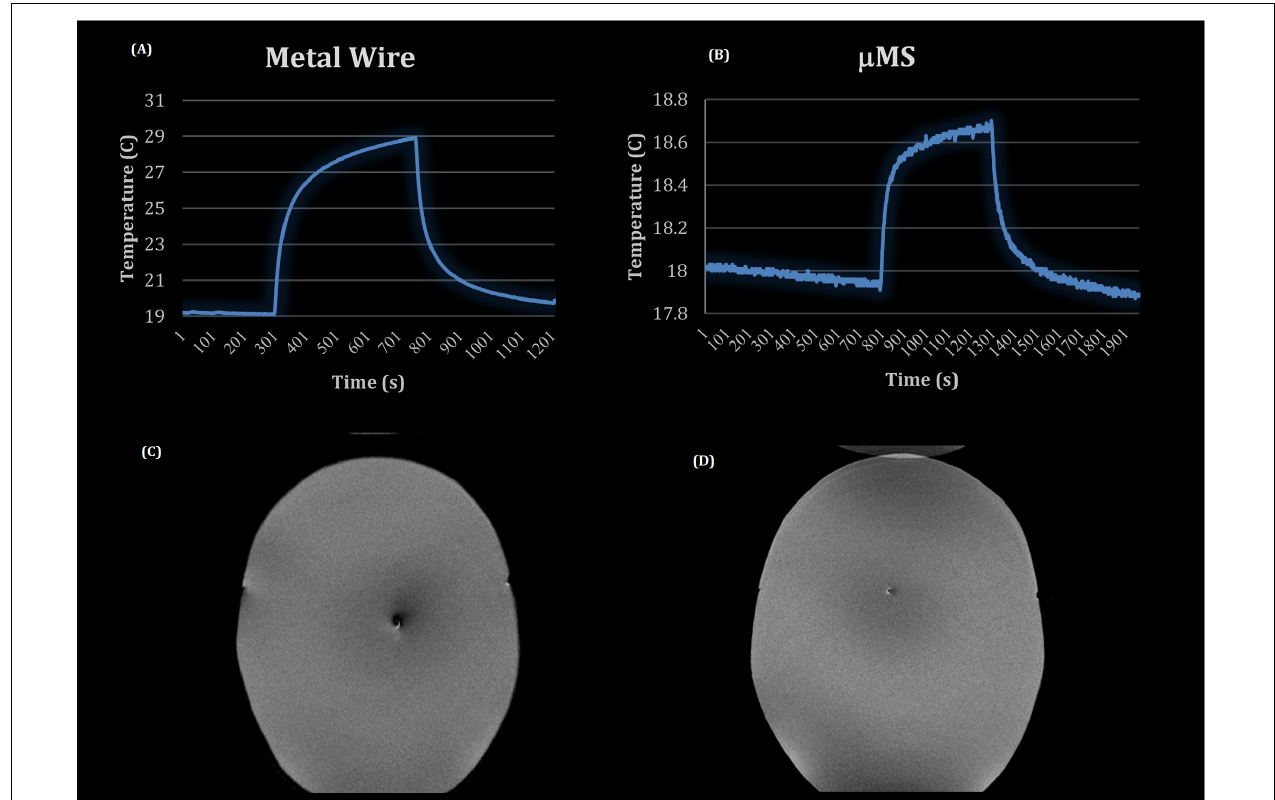
FIGURE 2 | MRI experiments: temperature profiles for the metal wire (A) and the µ MS coil (B) , T2 images of the CHEMA phantom with (C) the metal wire implanted and (D) with the µ MS coil